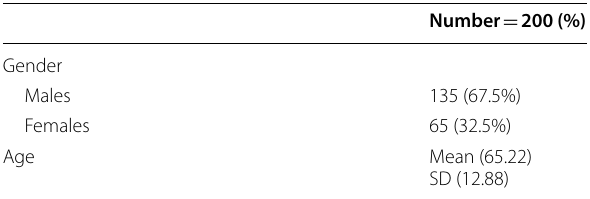
Table 1 Demographic characteristics among ischemic stroke